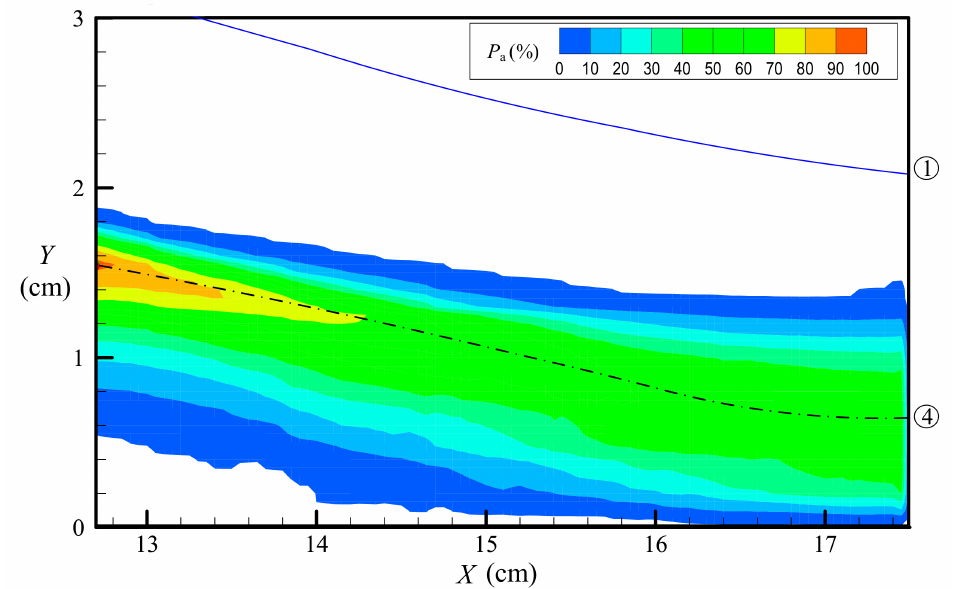
Figure 17. Spatial variation of the probability for intermittent occurrence of air bubbles, along with exhibition of the first water–air interface (labeled with 1 (cid:13) ) and the virtual boundary ( 4 (cid:13)